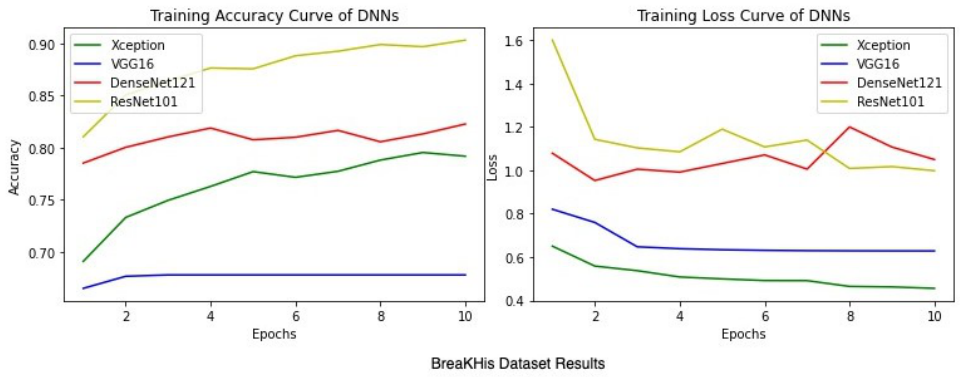
Figure 11. Average training accuracy and aoss of 5 folds for the BreaKHis